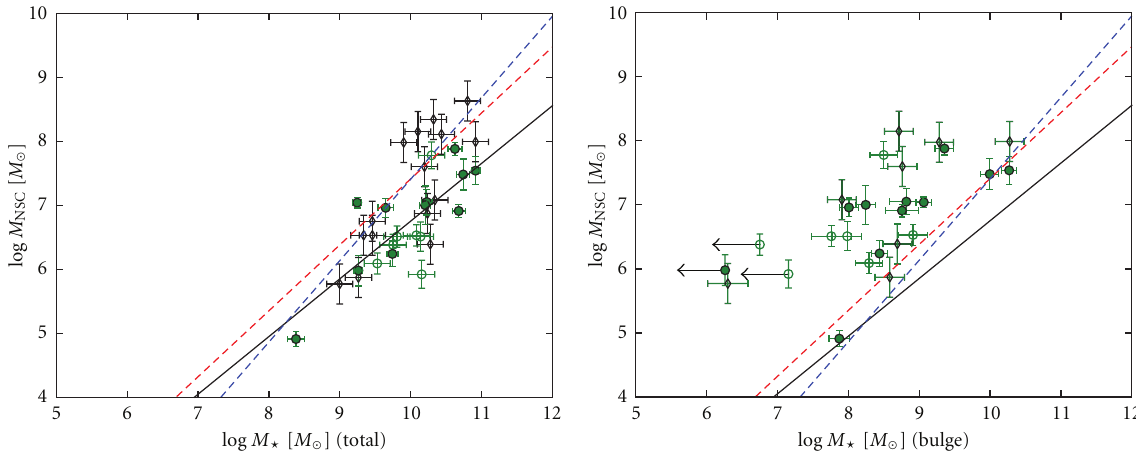
Figure 3: As for Figure 2, but now plotting NSC mass versus total stellar mass (a) and bulge stellar mass (b) (Data and sources in Table 2). Green circles are galaxies with dynamical mass estimates for their NSCs; black diamonds are the spectroscopically estimated masses of Rossa et al. [11] (bulge mass estimates are not complete for these galaxies). Filled symbols indicate galaxies with direct distance measurements (e.g., from Cepheid stars). Arrows show nominal upper limits for three bulgeless spirals (assuming that B/T ≤ 0 . 001). The diagonal black line is a fit of NSC mass to total stellar mass for the dynamical-mass sample (green circles); for comparison, the diagonal dashed red and blue lines are the M BH - M (cid:2) ,bul fits for ellipticals (red) and disk galaxies (blue) from Figure 2. The situation is now the reverse of that for SMBHs: NSC masses clearly correlate better with total galaxy mass than they do with bulge